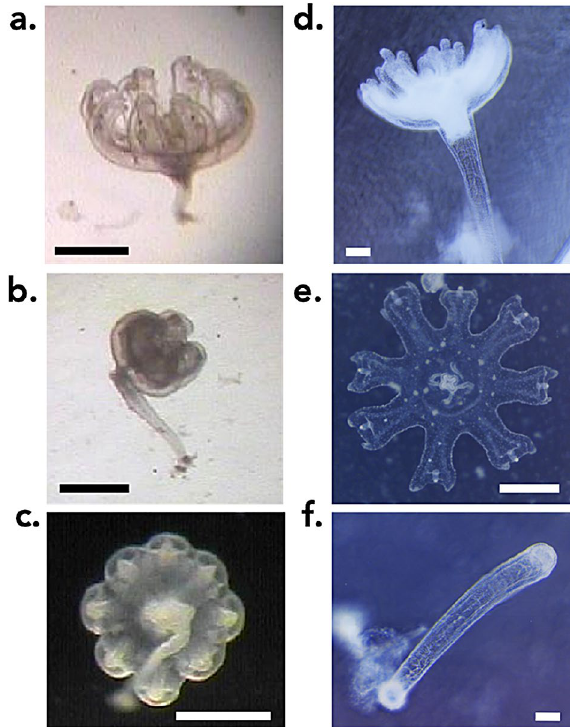
Figure 1. Indirect development sequence in ( a – c ) Aurelia relicta Scorrano et al. 2017 from Mljet (Croatia); ( d – f ) Cotylorhiza tuberculata (Macri 1778) from the bay of Pozzuoli (Italy). Scale bars = 500 µm.